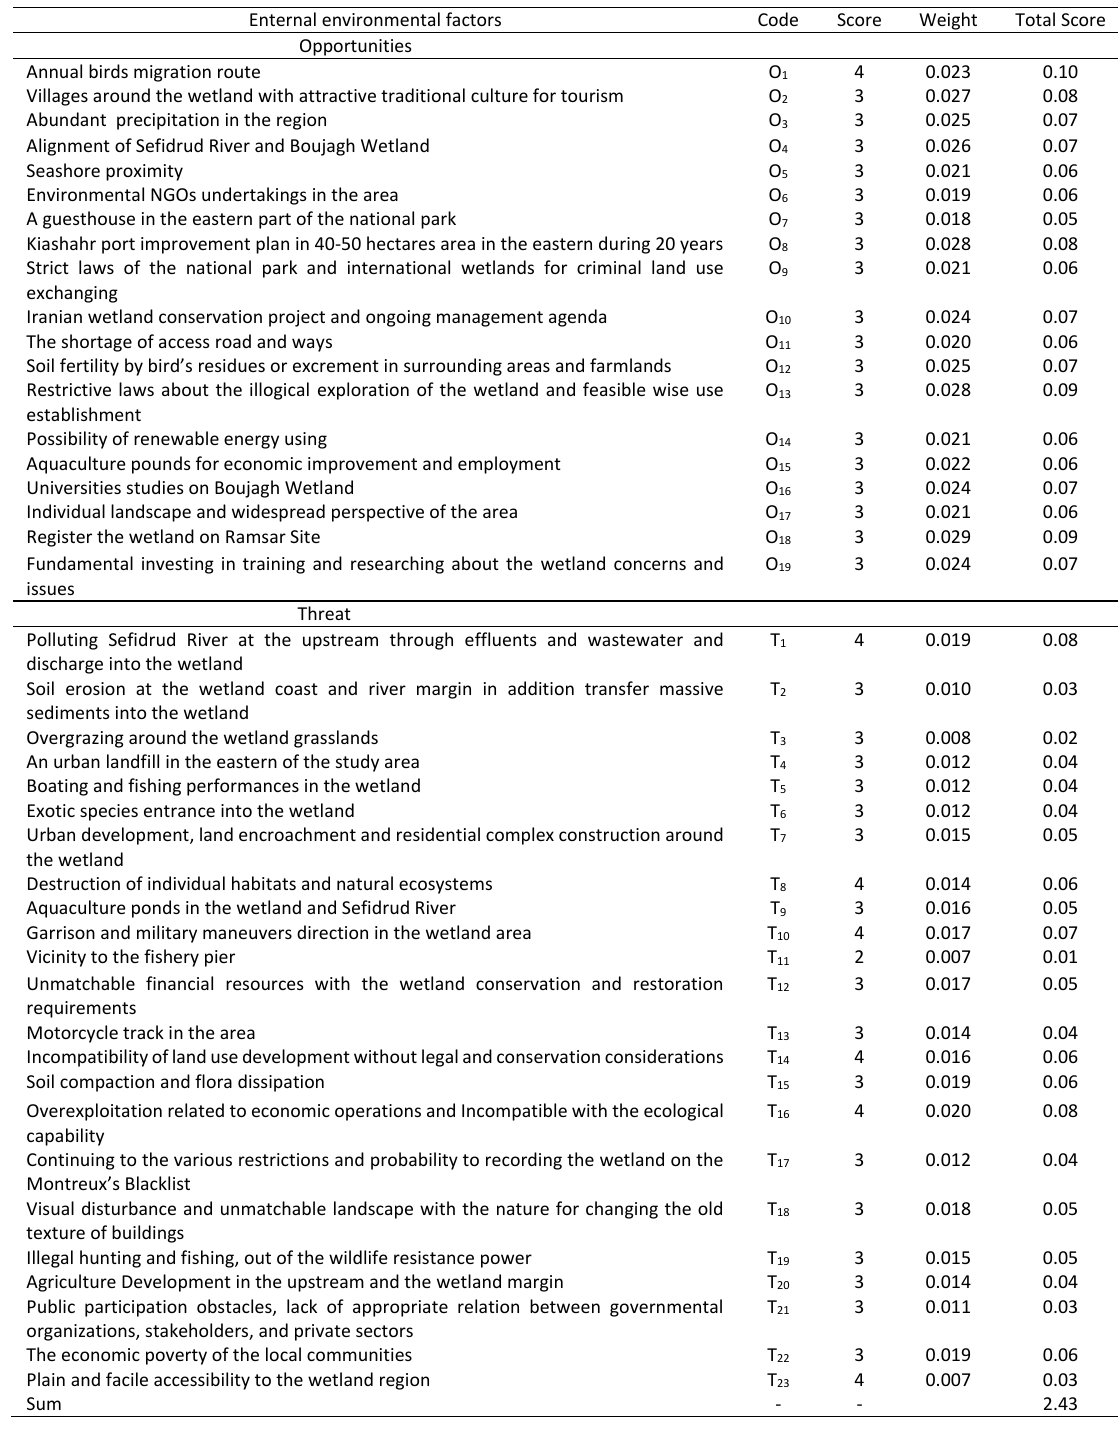
Table 3: EFEM of environmental management of Boujagh Wetland